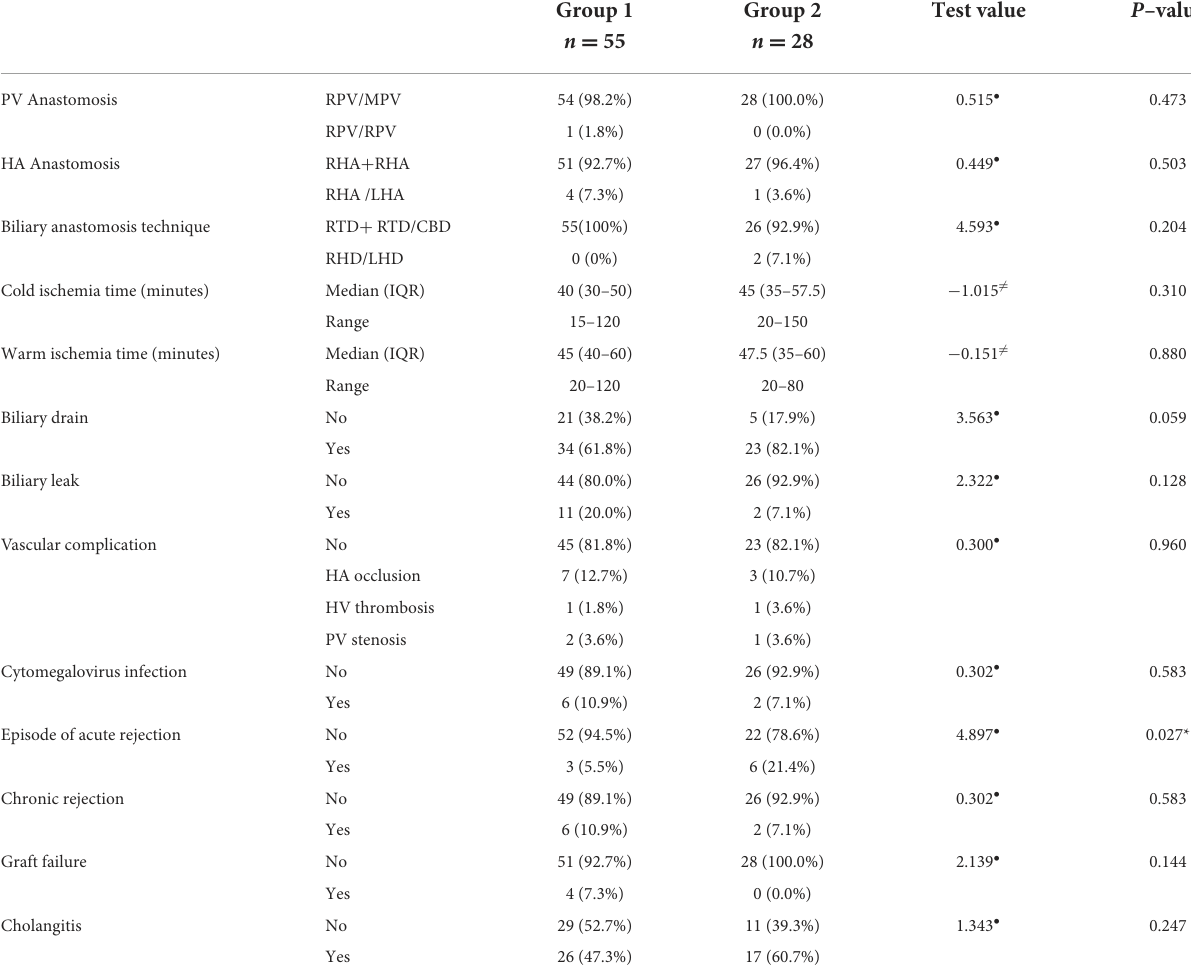
TABLE 2 The surgical technique used and post–transplant complications in the operation of the study